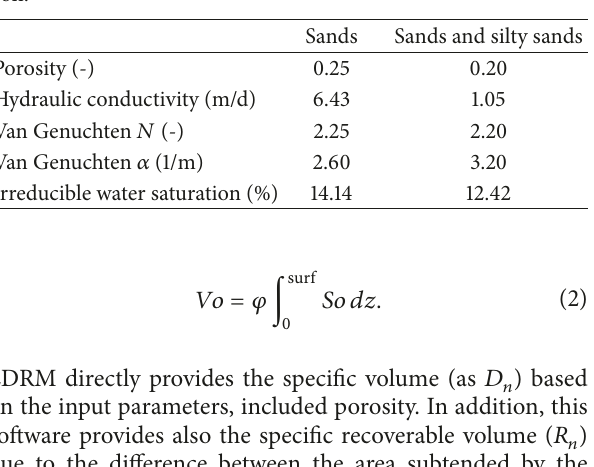
Table 2: Soil input parameters in LDRM for specific volume estima-